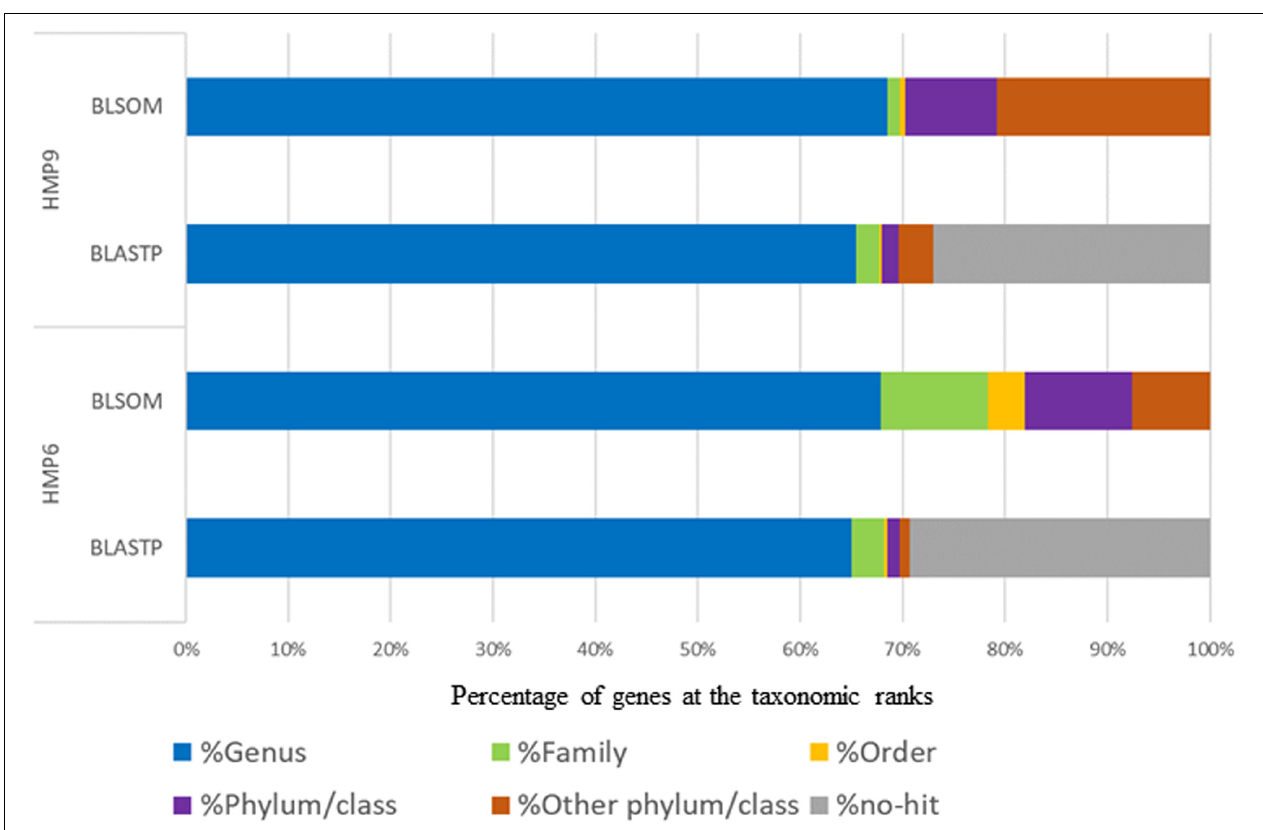
FIGURE 5 | Distribution of the detected genes in Antarctic HMP6 and HMP9 strains by BLSOM and BLASTp assigned according to taxonomic rank. The horizontal bars represent proportions of the detected genes assigned to each taxonomic rank by BLSOM and BLASTp with taxonomic ranks color-coded: genus ( (cid:4) ), family ( (cid:4) ), order ( (cid:4) ), phylum/class ( (cid:4) ), other phylum/class ( (cid:4) ), and no-hit ( (cid:4)